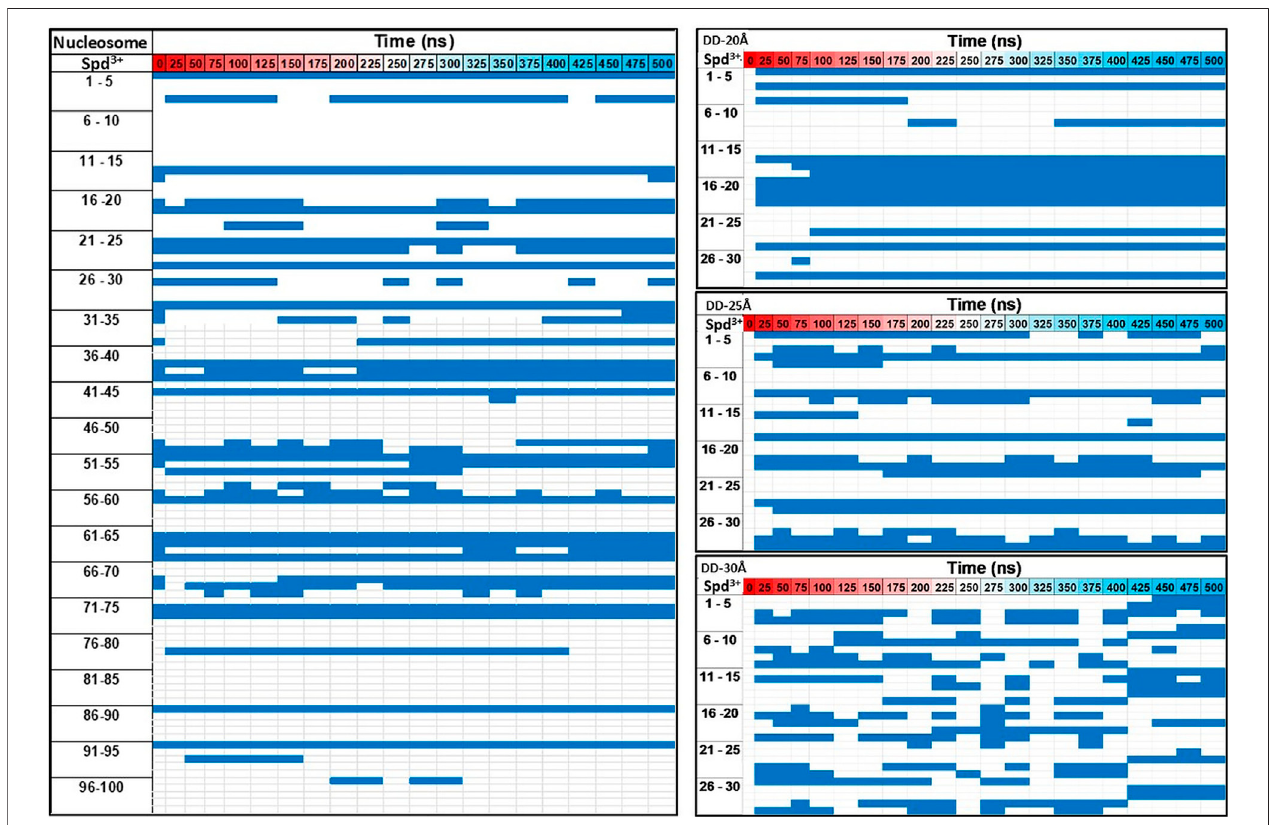
FIGURE 8 | Evolution of the movement of each Spd 3+ molecule with respect to the caged — uncaged position. The Spd 3+ are numbered from 1 to 30 for the DD systems and 1 to 100 for the nucleosome system, and the blue corresponds to the caged position.